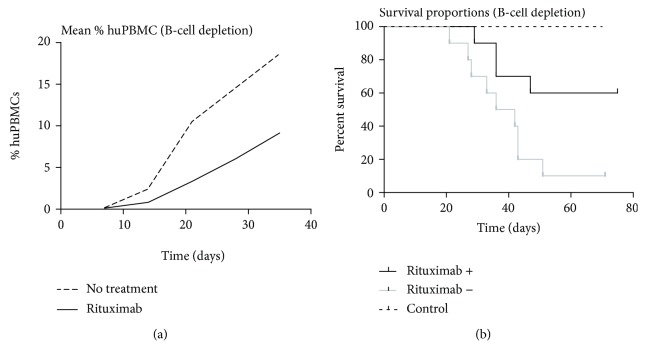
Survival and comparison of fraction reconstituted huPBMCs in B-cell depletion. (a) The difference in percentage of huPBMCs in mice either treated with Rituximab to induce B-cell depletion or not treated with Rituximab, and (b) a comparison of the survival portions between the RAG2 −/−γc−/− mice with and without Rituximab treatment versus control mice (n = 10), consisting of 5 RAG2 −/−γc−/− mice with Rituximab but no huPBMCs and 5 RAG2 −/−γc−/− control mice (with no Rituximab nor huPBMCs).